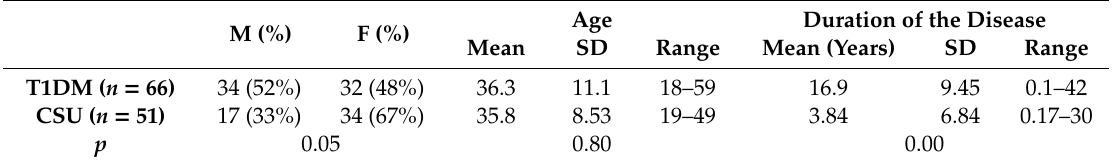
Table 1. Basic characteristic of study